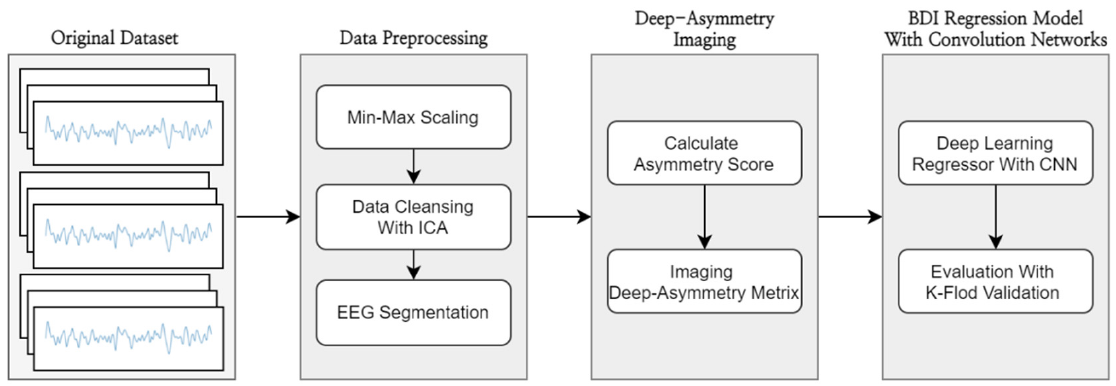
Figure 1. Schematic diagram of the entire pipeline of the